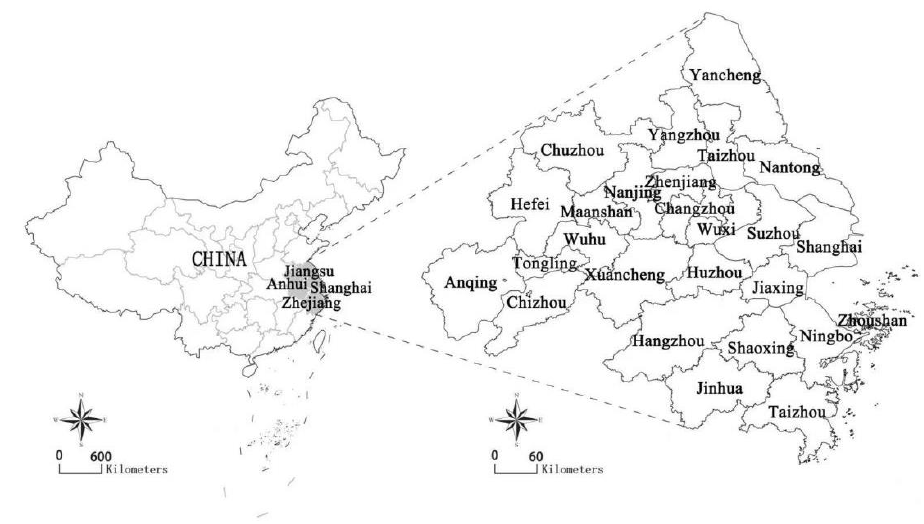
Figure 1. 26 prefecture-level cities in the YRD.